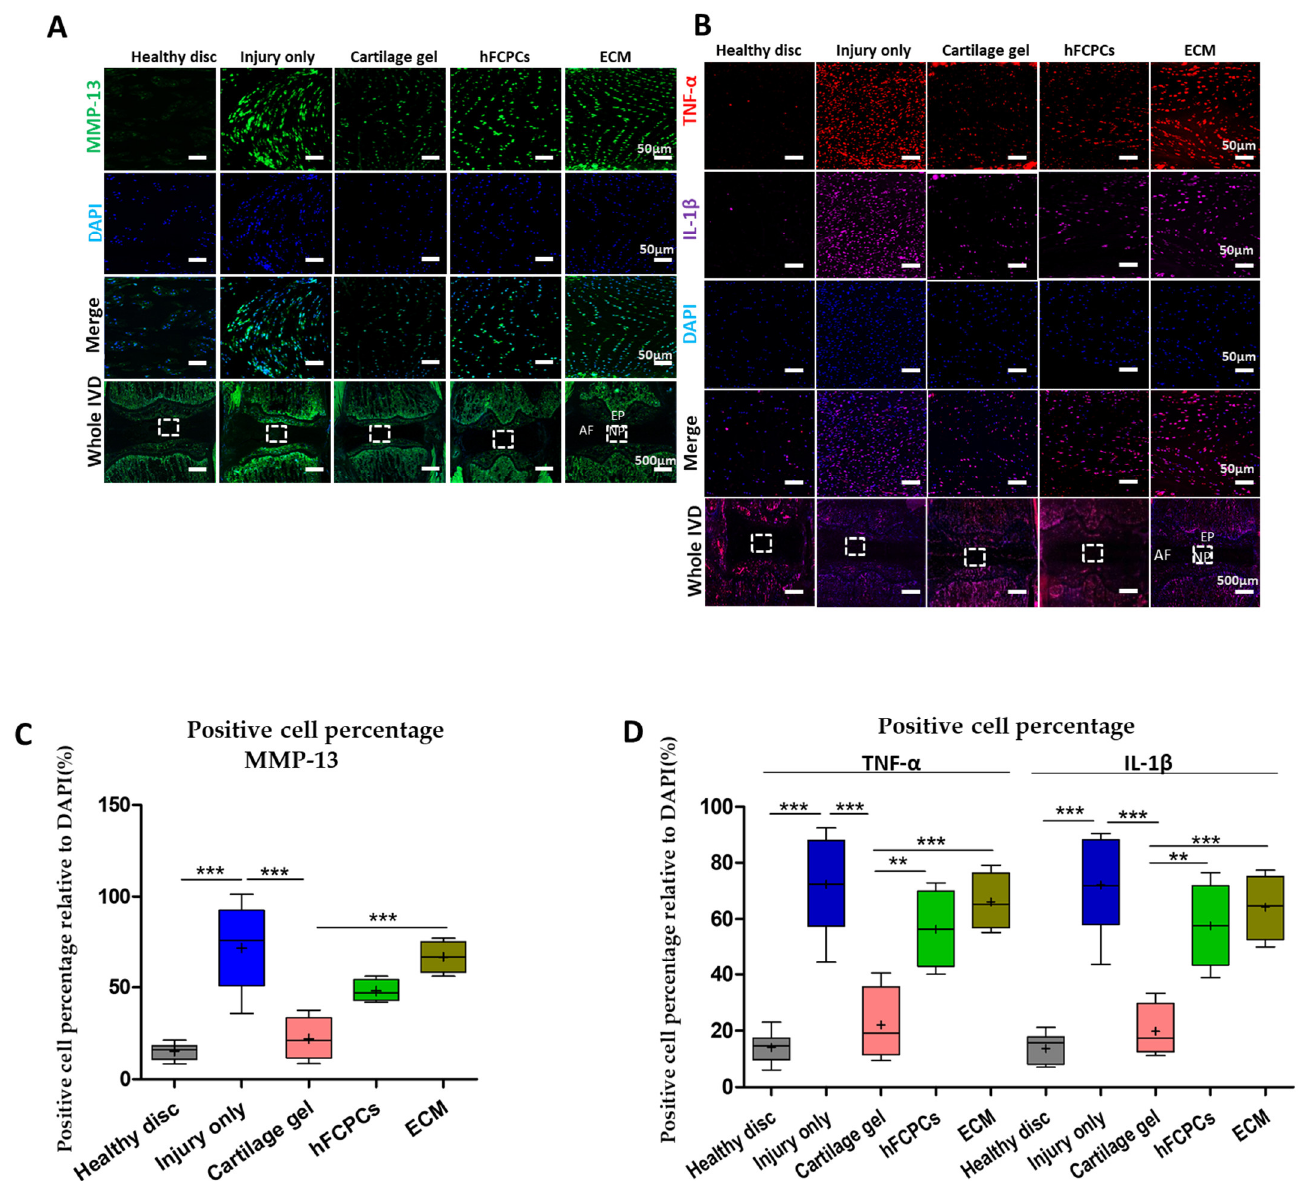
Figure 6. Cartilage gel downregulated catabolic and proinflammatory cytokines in the disc nucleus pulposus (NP) of a rat tail nucleotomy model. Immunofluorescence images of the indicated genes are presented for the healthy discs, injury-only discs, and the cartilage gel-injected, hFCPCs-injected, or ECM-injected discs at six weeks after surgery. ( A ) Immunofluorescence of the rat tail discs for matrix metalloproteinase-13 (MMP-13) (green), DAPI (blue), and merged signals. ( B ) Immunofluorescence of rat tail discs for tumor necrosis factor-alpha (TNF- α ) (red) and interleukin (IL)-1 β (purple), DAPI (blue) and merged signals. ( C ) Changes in the percentage of MMP-13-positive cells in the disc NP spaces. ( D ) Changes in the percentage of TNF- α - or IL-1 β -positive cells in the disc NP spaces. In ( C , D ) immunopositivity was counted in the disc NP with low-power fields and calculated as relative to the total number of DAPI-positive cells. Data are presented with box plots ( n = 4, ** p < 0.01, *** p < 0.001, significant difference by one-way ANOVA).